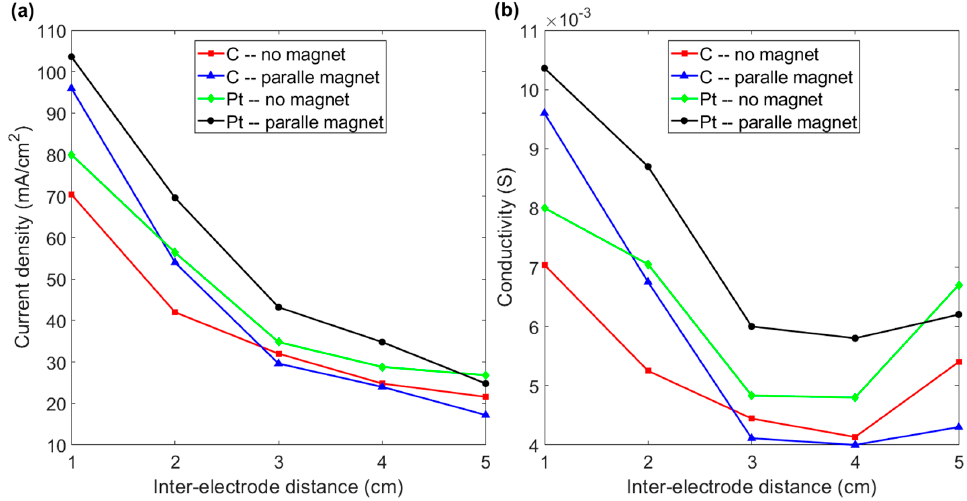
Figure 7. ( a ) Current density vs. inter-electrode distance for graphite and platinum electrodes with and without a magnet for various inter-electrode distances. ( b ) Conductivity vs. inter-electrode distance for the various experimental layouts in Figure 7a: the charging voltage is 200 V.